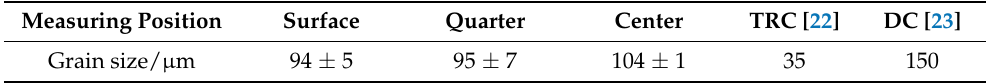
Figure 3. Macrostructure of as-cast AA6063. Table 3. Average grain size of VC slab and comparison with other processes. TRC reproduced from [22], with permission from publisher University of Science and Technology Liaoning, 2019. DC reproduced from [23], with permission from publisher J. Mater. Process. Technol,